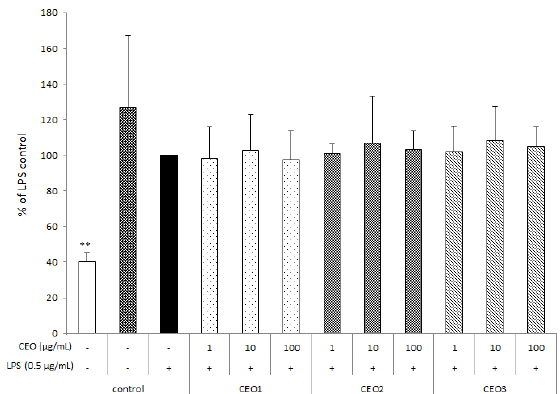
Figure 1. Effect of chinotto essential oils at different ripening stages [CEO1 (green), CEO2 (half ripe), and CEO3 (ripe)] on the cell viability of RAW264.7 macrophages. Cells were seeded in 96-well plates at a density of 2.5 × 10 5 cells mL −1 and, after overnight incubation, were treated with lipopolysaccharide (LPS, 0.5 μg mL −1 ) and with (or without) increasing concentrations of CEOs for 48 h. Data are presented as percentages and LPS control (without CEOs) was fixed at 100% (black bar). The white bar represents the positive control, corresponding to untreated cells upon addition of Triton X100. The means of three separate experiments (each done in duplicate) ± standard deviation are reported. Mean value was statistically different from control (** p < 0.01).